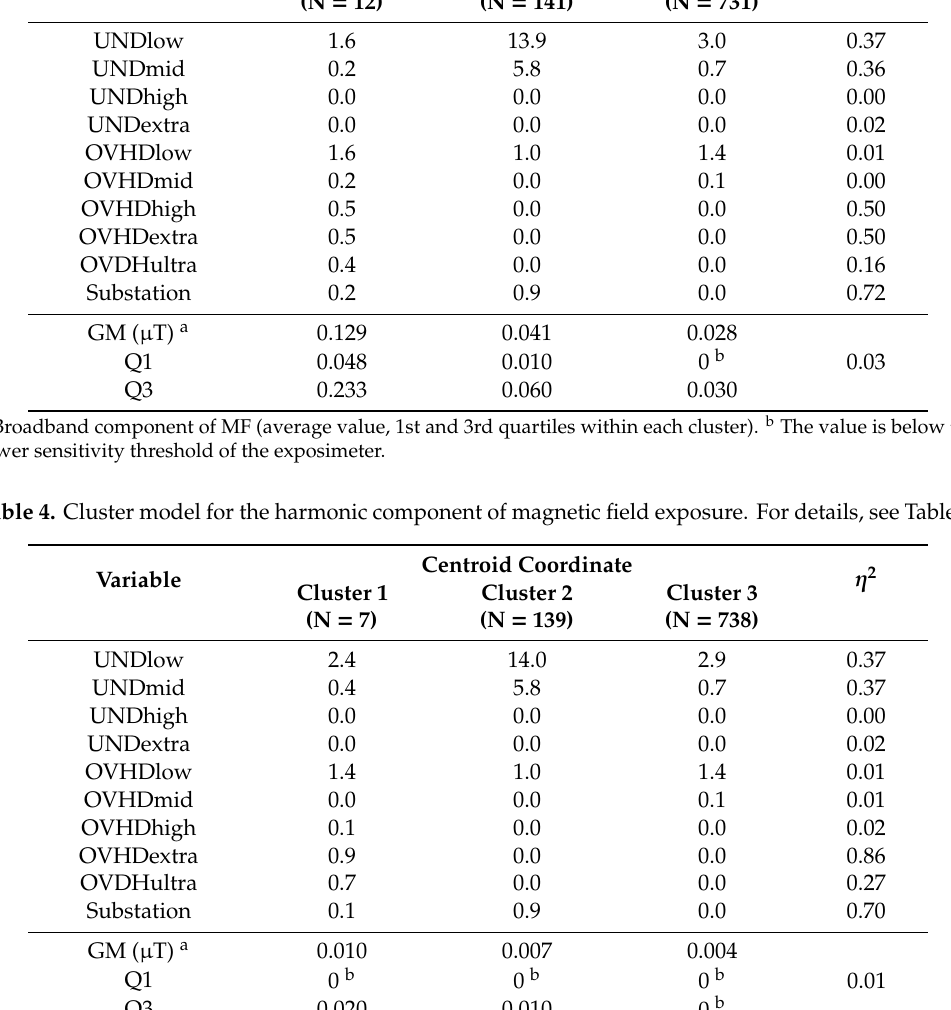
Table 3. Cluster model for the broadband magnetic field exposure. For details, see Table 2. Centroid Coordinate Variable